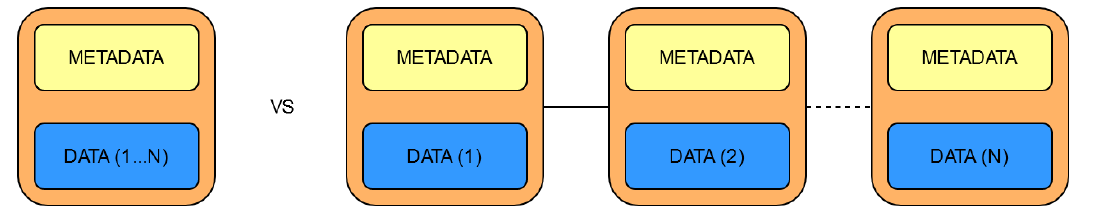
Figure 10. One block vs. more blocks – same amount of